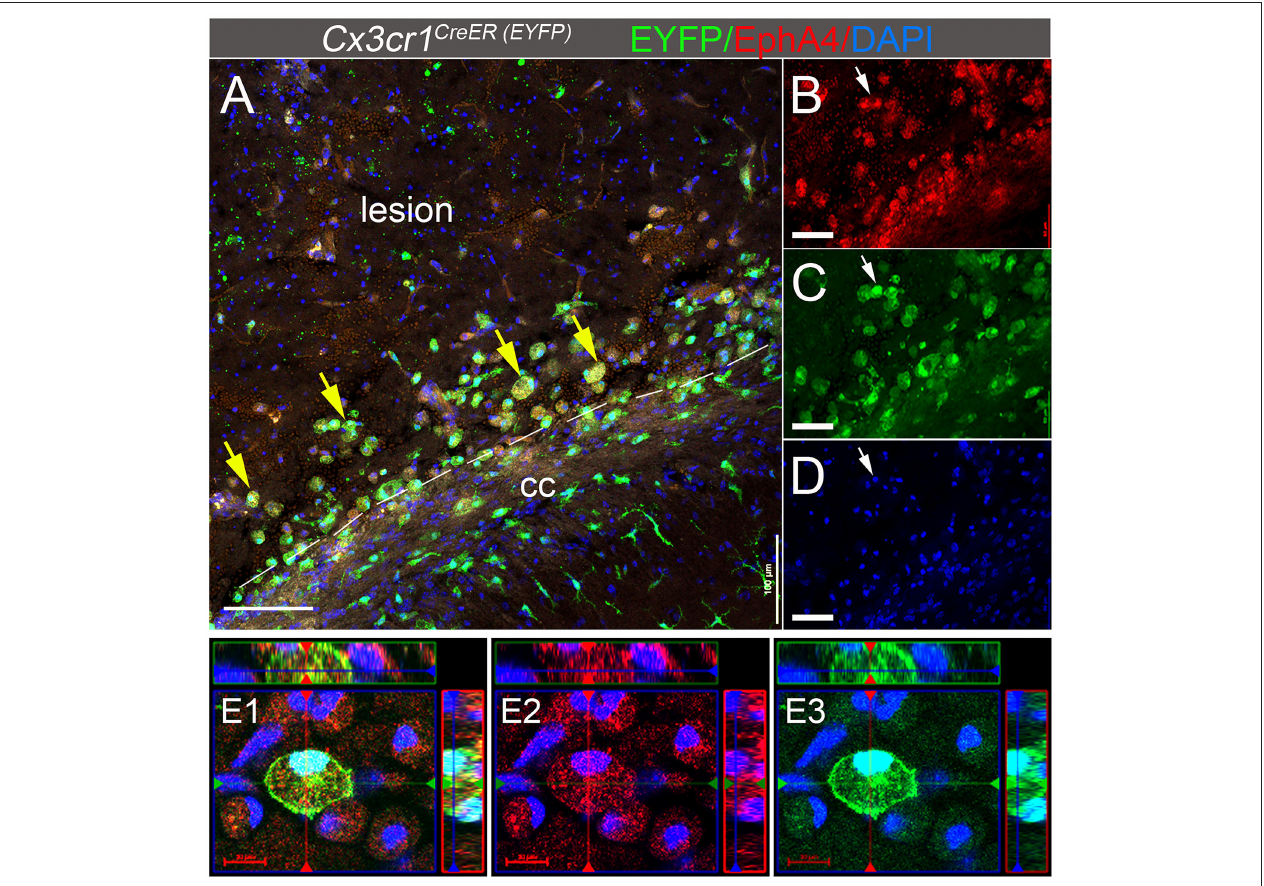
FIGURE 1 | EphA4 is upregulated on Cx3cr1-expressing cells in the peri-lesion 3 days post CCI injury. (A–D) Representative confocal images at max z-projection for immunohistochemical analysis for EphA4 (red), EYFP in Cx3cr1-expressing cells (green), and DAPI (blue) at 3 dpi in the ipsilateral cortex of Cx3cr1 CreER / + mice. CCI injury increased EphA4 expression in cx3cr1 + cells (arrows) in the peri-lesion areas. (E1–E3) Co-localization of EphA4 and EYFP in amoeboid-shaped microglia and/or PDM. Scale bar: (A) 100 µ m; (B–D) 50 µ m and (E1–E3) 20 µ